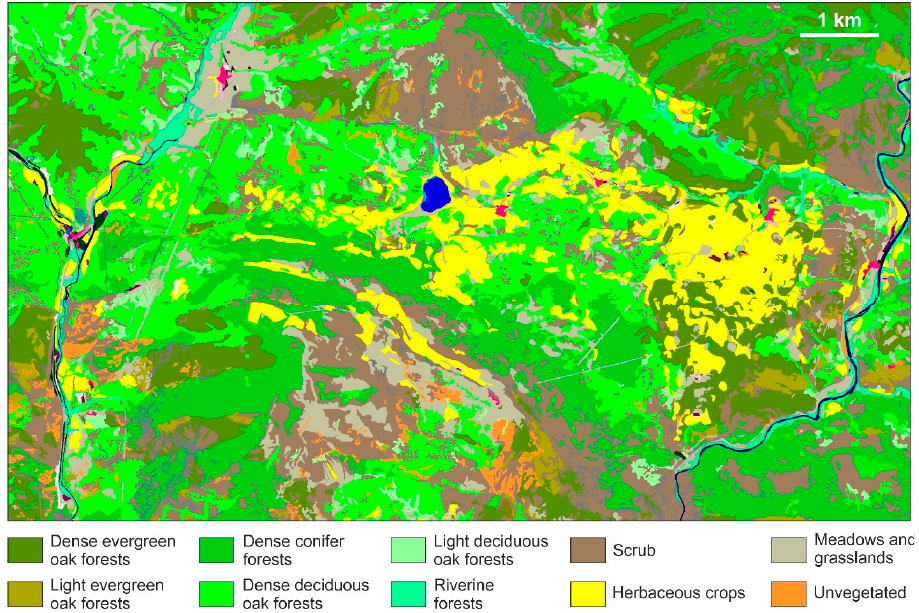
Figure 3. Vegetation map (forests in green tones) of the region surrounding Lake Montcortès (central blue patch). Red patches are urban areas. Map downloaded from the public service of the Institut Cartogràfic i Geològic de Catalunya (ICGC) (https://www.icgc.cat/, last accessed 18 March 2022).